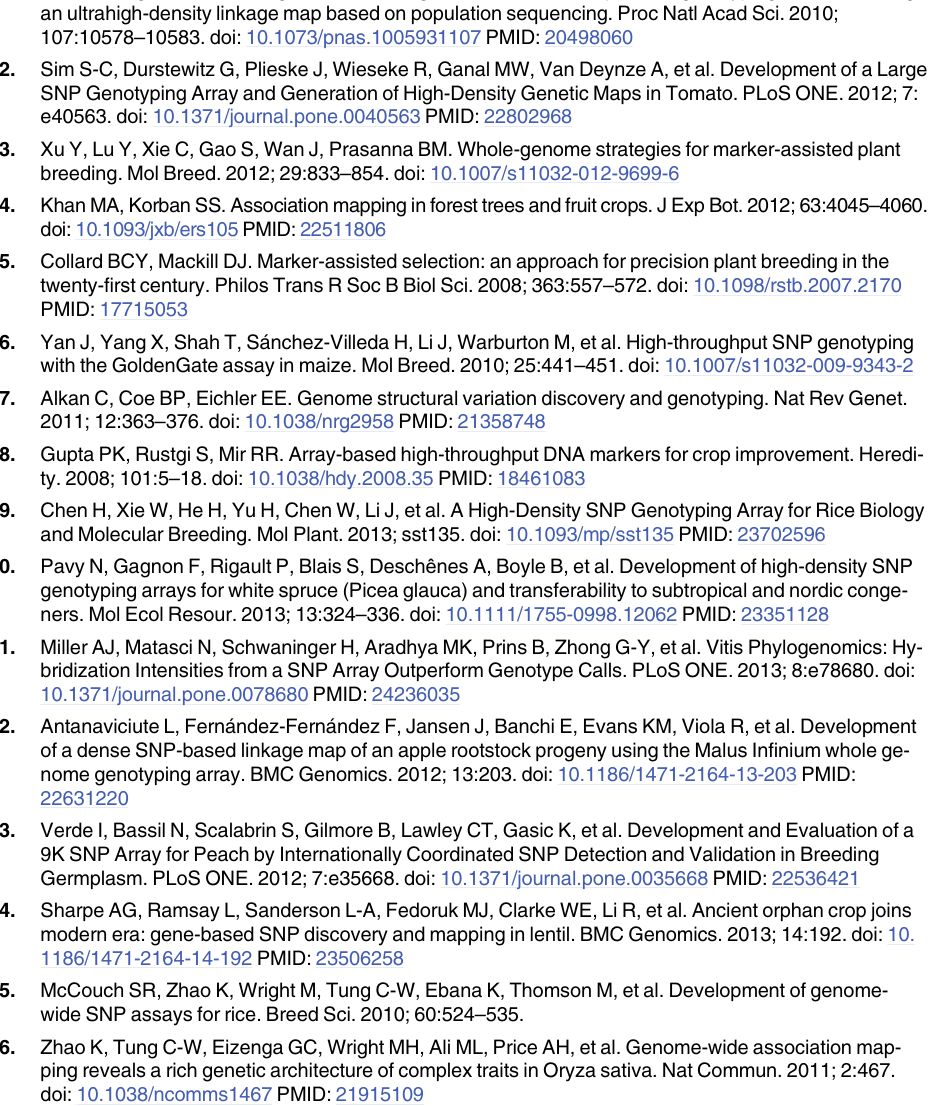
S4 Fig. Dot plot of the ‘ Gy14 ’ (V1.0) vs. ‘ 9930 ’ (V2.0) genomes with SyMap Version 4.